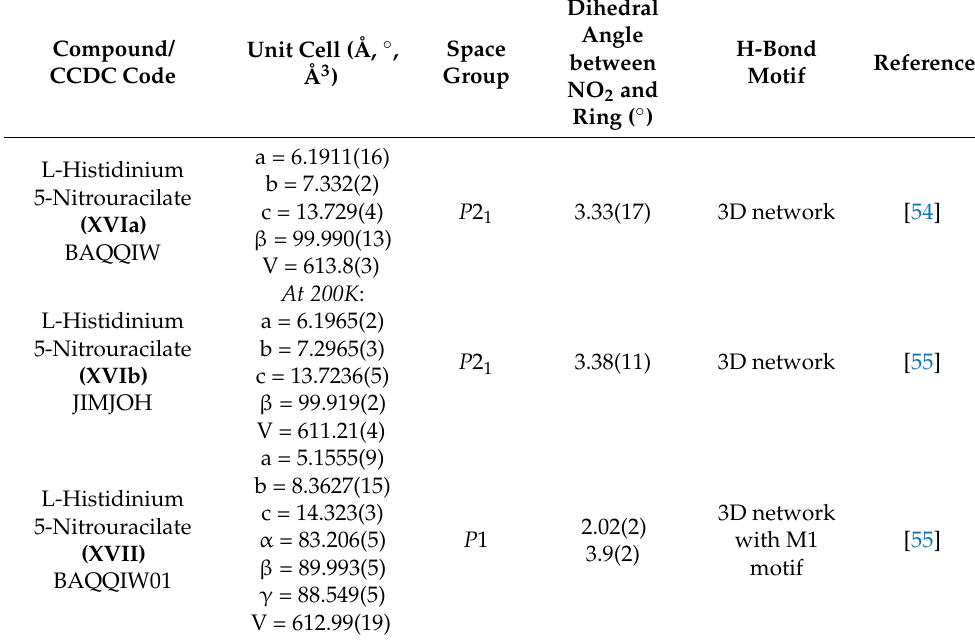
Dihedral H-Bond Motif